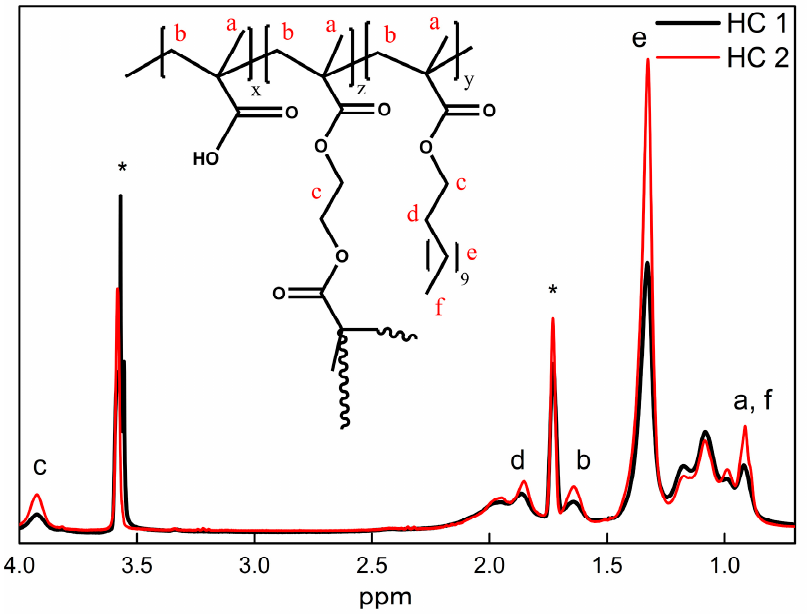
Figure 2. 1 H-NMR spectra of the HCs in THF-d8. (The letters represent peak assignments and the star symbol (*) is attributed to THF-d8).